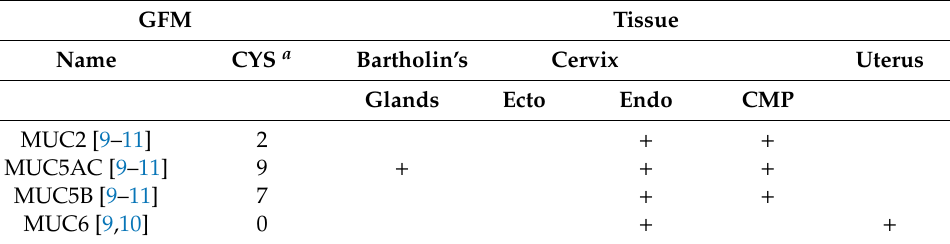
Table 1. Gel-forming mucins (GFMs) in the woman’s genital tract.